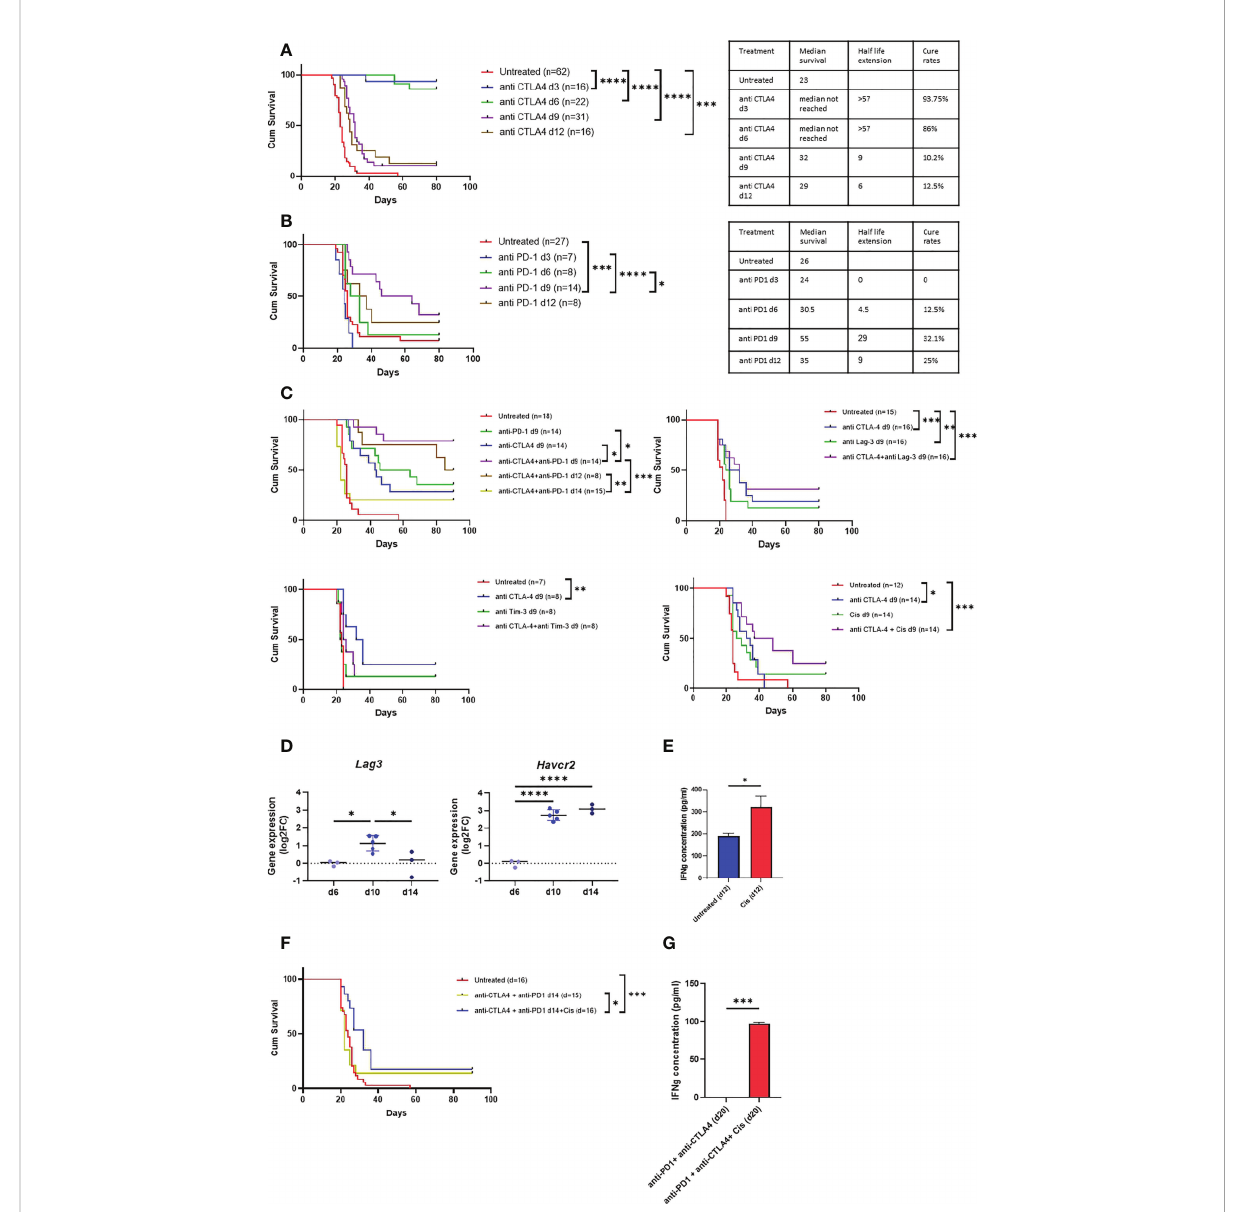
FIGURE 6 Anti MPM immunotherapy in AB12 tumor model. A-B. Tumor phase dependent ef fi cacy of single agent immunotherapy. The Kaplan-Meier survival curves show the response of AB12 tumors to treatment with either anti CTLA-4 (A) or anti PD-1 (B) when initiated on d3, d6, d9 or d12. The tables show the median survival, the half-life extension period and the cure rates for each treatment and time point. (C) Differential expression Havcr2 and Lag3 genes between d6, d10 and d14 AB12 tumors. The dot plots show the fold-changes (FC) of gene expression relative to the mean of d6 tumors of Havcr2 (TIM-3) and Lag3 (LAG-3) genes, based on RNA-Seq data. The p -values of the post hoc Tukey test are indicated at the top of the dot plots. (D) Responsiveness of splenocytes to cisplatin treated AB12 cells in vitro . AB12 cells were either treated or not with cisplatin. The levels of IFNg protein in the medium were measured by ELISA in tumor cells co-cultured with splenocytes. (n=3). (E) Ef fi cacy of combination immunotherapy against AB12 tumors. The Kaplan-Meier survival curves show the response of AB12 tumors to treatment with several combinations of immunotherapy. The responses to anti CTLA-4 + anti PD-1 initiated on d9, or d12 or d14 (upper left), anti CTLA-4 + anti LAG-3 initiated on d9 (upper right), anti CTLA-4 + anti TIM-3 initiated on d9 (lower left), anti CTLA-4 + cisplatin initiated on d9 (lower right) are shown. (F) Ef fi cacy of anti CTLA-4 + anti PD-1 + cisplatin against advanced AB12 tumors. The Kaplan-Meier survival curves show the response of AB12 tumors to treatment with either anti CTLA-4 + anti PD-1 or anti CTLA-4 + anti PD-1 + cisplatin initiated on d14. (G) Responsiveness of splenocytes derived from anti CTLA-4 + anti PD-1 + cisplatin treated mice to AB12 cells in vitro. Splenocytes were derived on d20 from tumor-bearing mice that were treated on d14 with either anti CTLA-4 + PD-1 or anti CTLA-4 + PD-1 + cisplatin. The levels of IFNg protein were measured by ELISA in the medium of tumor cells co-cultured with splenocytes. (n=3). The p -values of the unpaired T test are indicated at the top of the histogram ( D, G ). The differences between survival curves were calculated by the log-rank test ( A, B, E , F ). FC: Fold-Change; cis: cisplatin. * p ≤ 0.05; ** p ≤ 0.01; *** p ≤ 0.001; **** p ≤